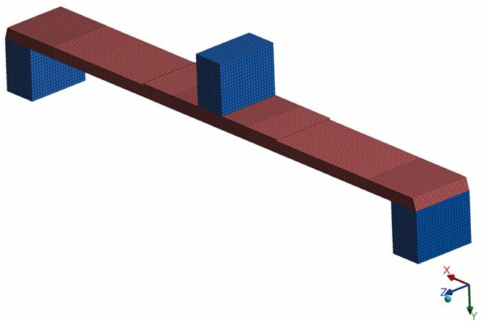
Figure 3. Numerical model of a replaceable measuring head intended for the compliant